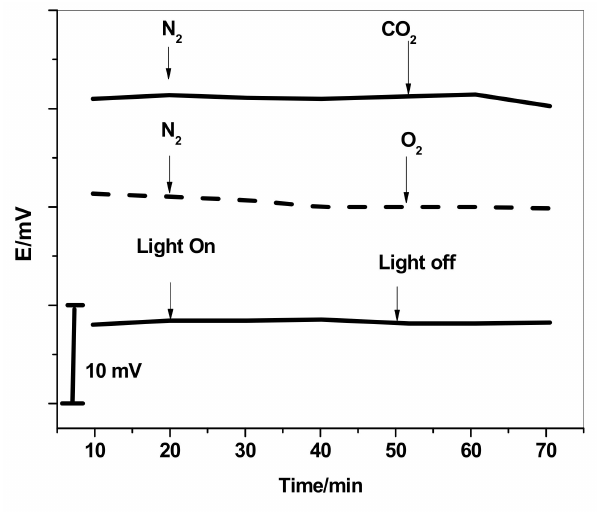
Figure 6. Robustness of the